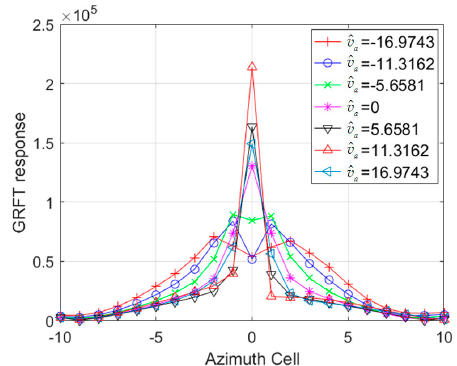
Figure 6. Azimuth profile of GRFT responses to azimuth velocity searching.